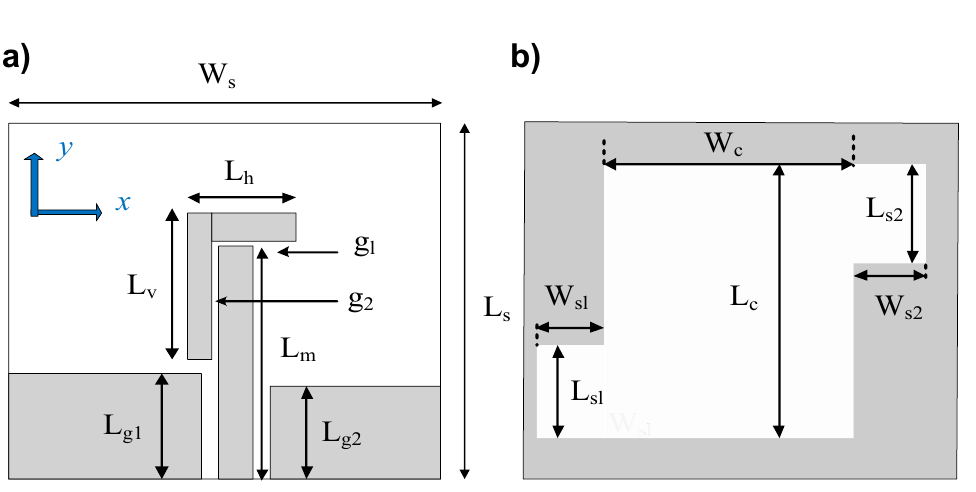
Figure 4. Wide-slot CP antenna 46 : ( a ) front view, ( b ) back